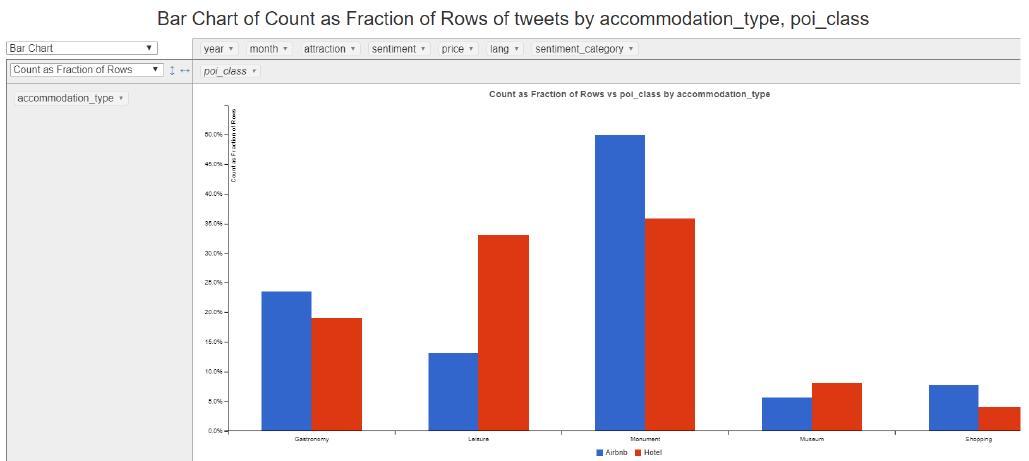
Figure 15. Tweets per accommodation and type of